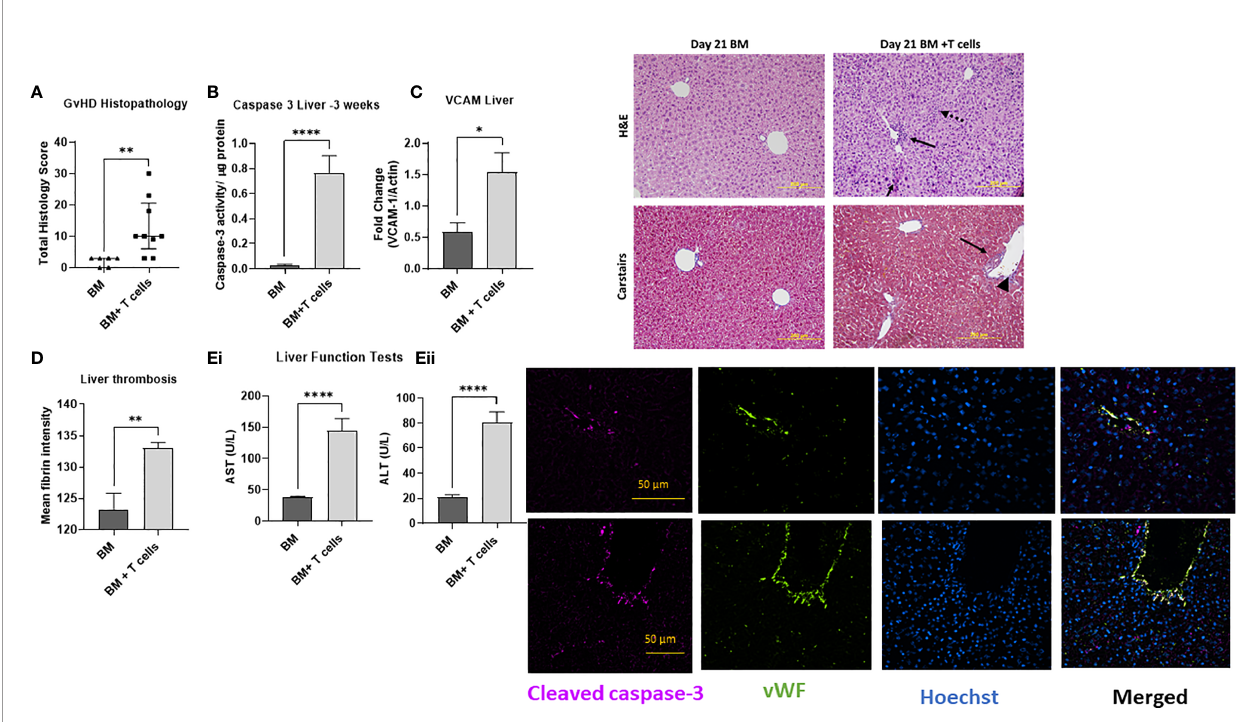
FIGURE 6 | Established GvHD, endothelial and hepatic SOS at d21 post-transplant of BM + T-cells (A) with increased histopathological signs of GvHD (Data is median and interquartile range, *=p<0.05 Mann-Whitney U-test. (B) Augmented caspase-3 activity con fi rms signi fi cant liver damage and (C) VCAM-1 upregulation. Hepatic SOS is evidenced by (D) increased fi brin deposition and (E) impaired liver function with increased levels of (i) aspartate aminotransferase (AST) and (ii) alanine aminotransferase (ALT) are also noted. **p < 0.005, ****p < 0.00005, unpaired Student ’ s t-test, n=6 naïve; n=6 BM and n=9 BM+T cells. Data is Mean ± SEM. Image: H&E images show periportal in fl ammation (solid arrows) and sinusoidal in fi ltration (dotted arrows) which Carstairs image (blue depicts collagen, dark red- Fibrin and yellow-red blood cells) shows abundant fi brin deposition with parenchymal mitotic fi gures (long arrow) and vascular endothelialitis (arrowhead) remaining visible. Immuno fl uorescence staining shows speci fi c cleaved caspase-3 immunoreactivity colocalizing with endothelial cells positive for vWF in both large and small vessels, with Hoechst used as a nuclear counter-stain. Merged images con fi rm presence of apoptotic endothelial